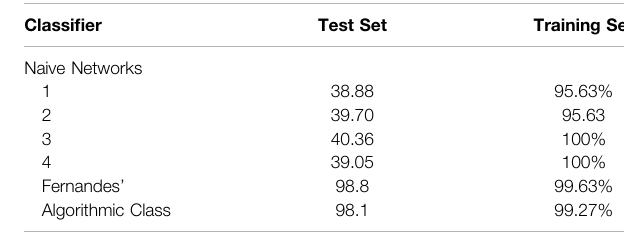
TABLE 1 | The accuracy of the Tested Classi fi ers.